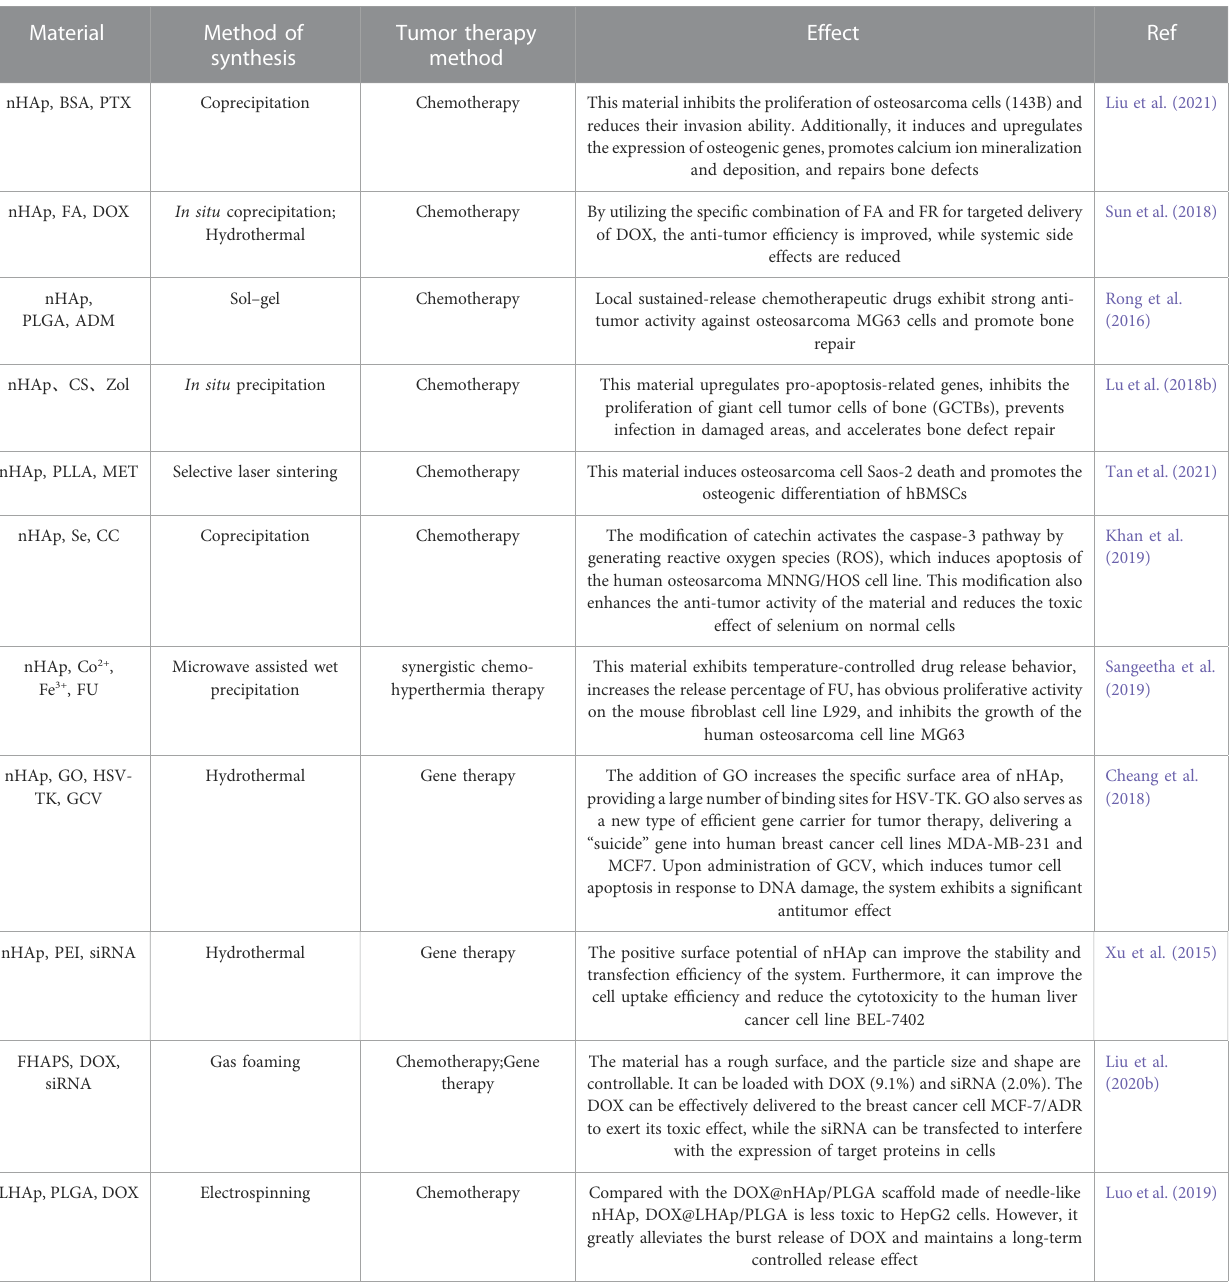
TABLE 1 The role of nHAp in antitumor drug delivery